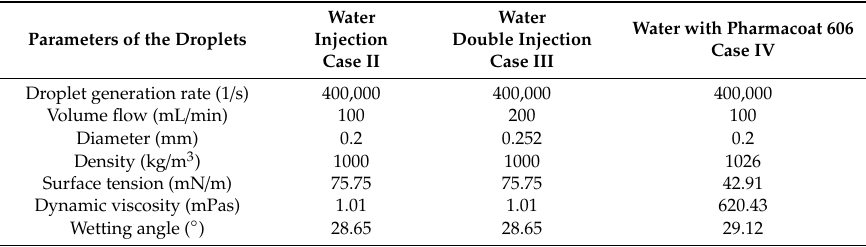
Table 4. DEM simulation parameters for the droplets.